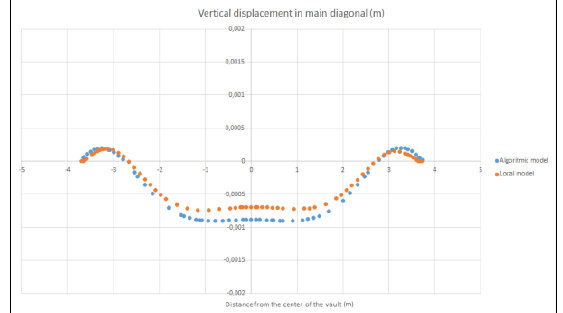
Figure 14. Displacements trends on main diagonals. Blue points refer to algorithmic model and orange ones refer to local model generated in Rhino.